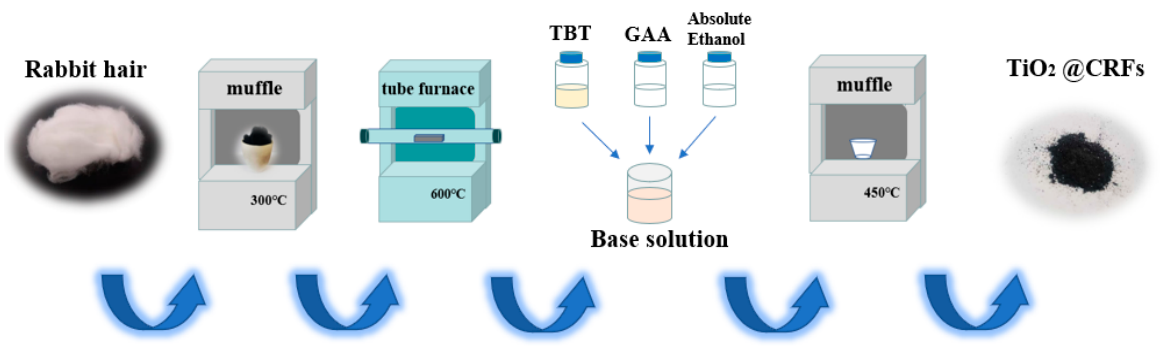
Figure 1. Schematic of the formation of TiO 2 /CRFs composite